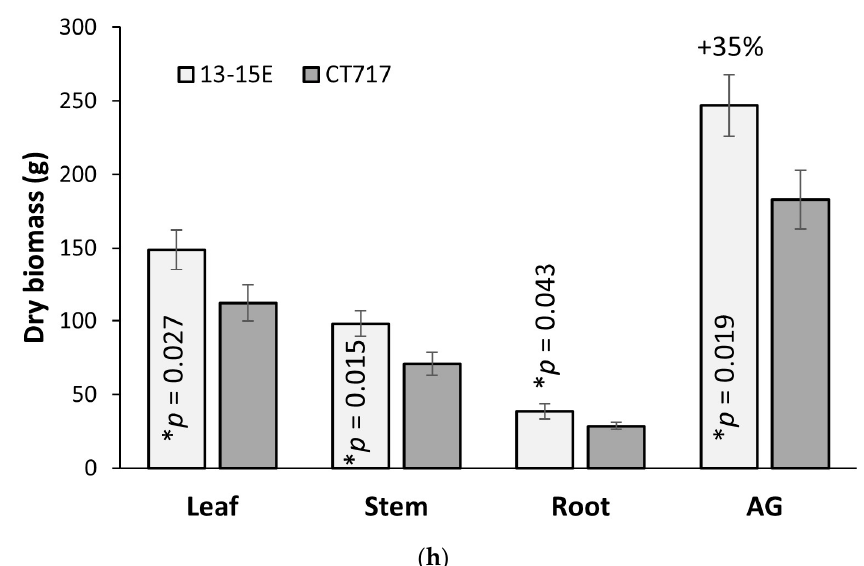
Figure 5. Transgene expression, photosynthetic activity, and plant growth analysis of C2 repeat experiment with the lead event. A repeat experiment was carried out with the lead event, 13-15E and non-transgenic control CT717-3. ( a ) PLGG1 expression in 13-15E and CT717-3. Tissue samples were collected from Leaf 8 with five ramets per event at Week 8. ( b – e ) Photosynthetic parameters determined from A-Ci curves performed on five ramets each of 13-15E and CT717-3: ( b ) A max (CO 2 assimilation rate at saturating light and CO 2 concentration). ( c ) J max (maximum rate of photosynthetic electron transport). ( d ) Vc max (maximum rate of carboxylation). ( e ) J max :Vc max ratio. ( g ) A-Ci curve of 13-15E and CT717-3, five ramets each, error bars represent SEM. ( f ) Stem volume in 13-15E and CT717-3 at Week 14. ( h ) Biomass measurement of harvested C2 experimental plants in dry weight. Number of ramets: five per event. *, ** and **** represents a significant difference at p < 0.05, p < 0.01, and p < 0.0001 respectively when compared to non-transgenic